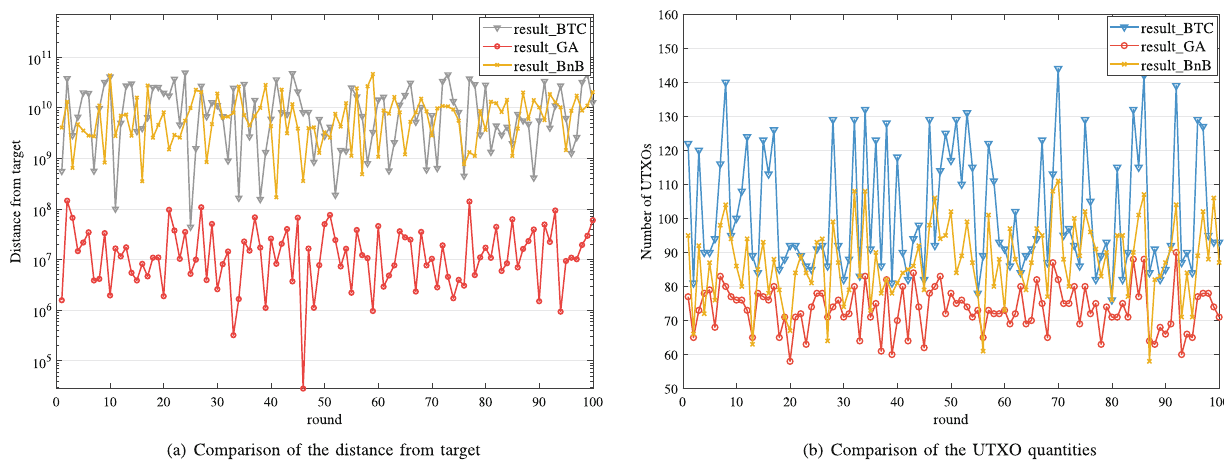
Fig. 11 Comparison of 100 rounds results in real bitcoin account (bitcoin